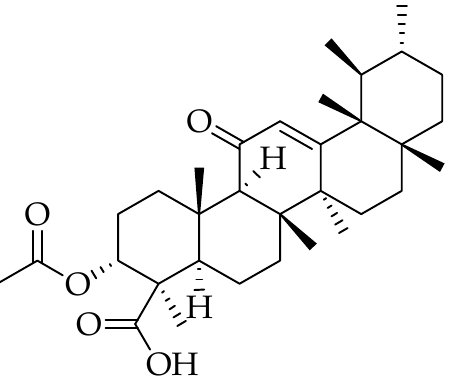
Figure 13. The chemical structure of acetyl-11-keto- β -boswellic acid.